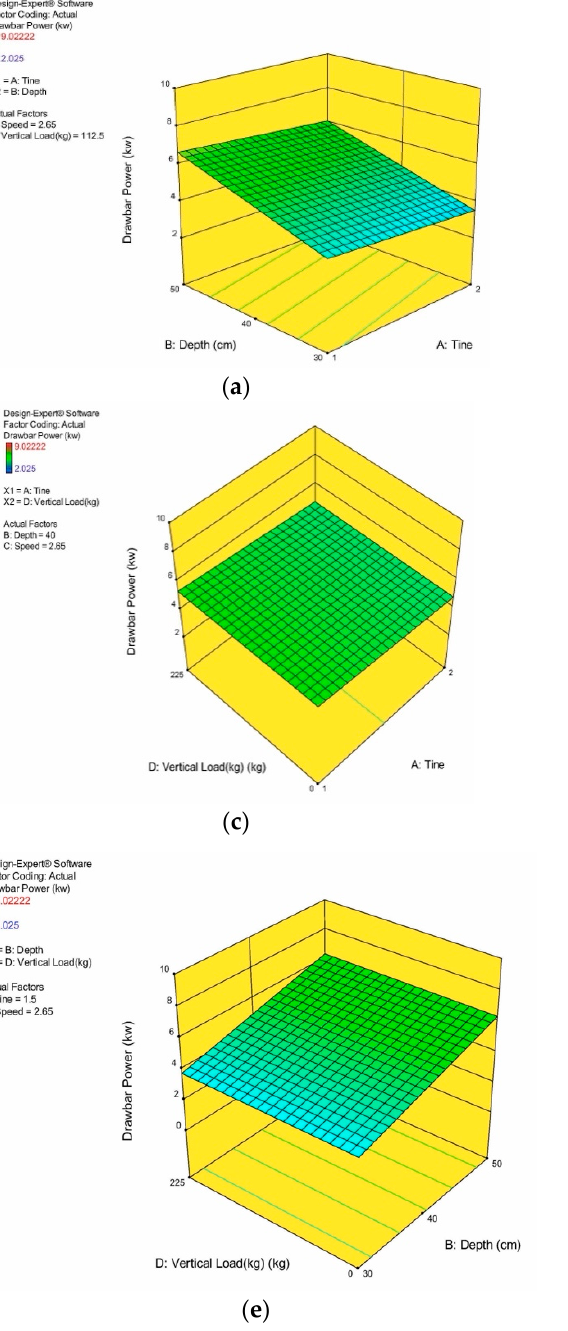
Figure 8. 3D surface curves of drawbar power as influenced by interactions between input parameters using the RSM approach; ( a ) tine and depth, ( b ) tine and speed, ( c ) tine and vertical load, ( d ) depth and speed, ( e ) depth and vertical load, ( f ) speed and vertical load.